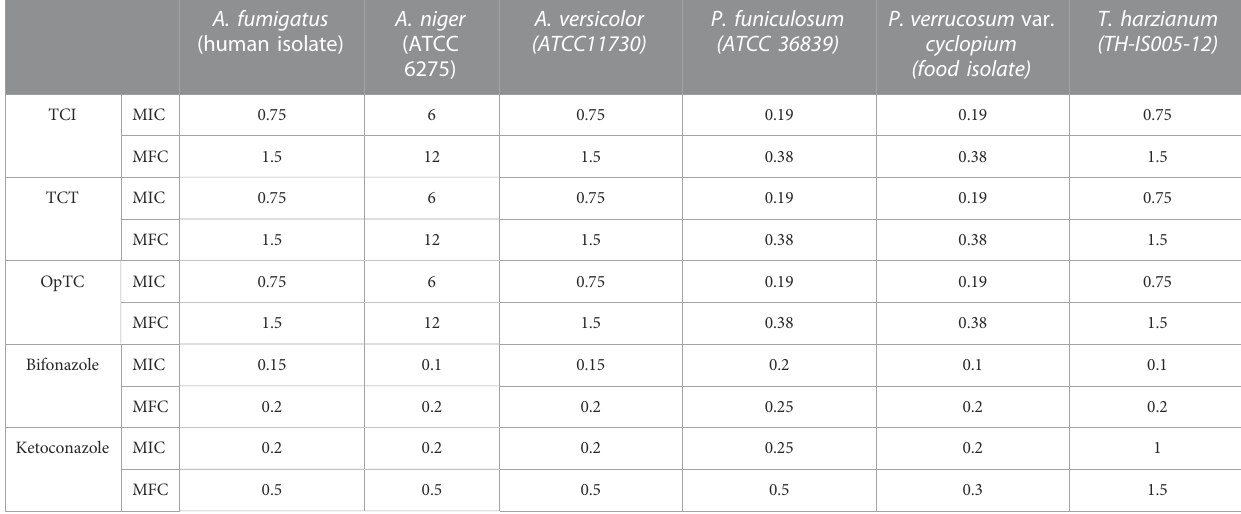
TABLE 5 MIC and MFC values (mg/ml) of the herbal preparations obtained from Thymus comosus after the evaluation of their antifungal